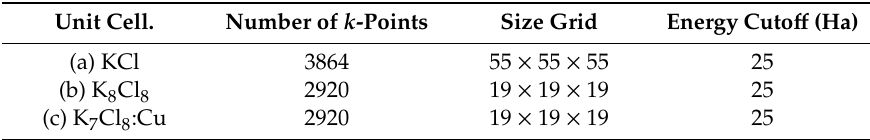
Table 1. Parameters employed in the present study’s calculation. Unit Cell.